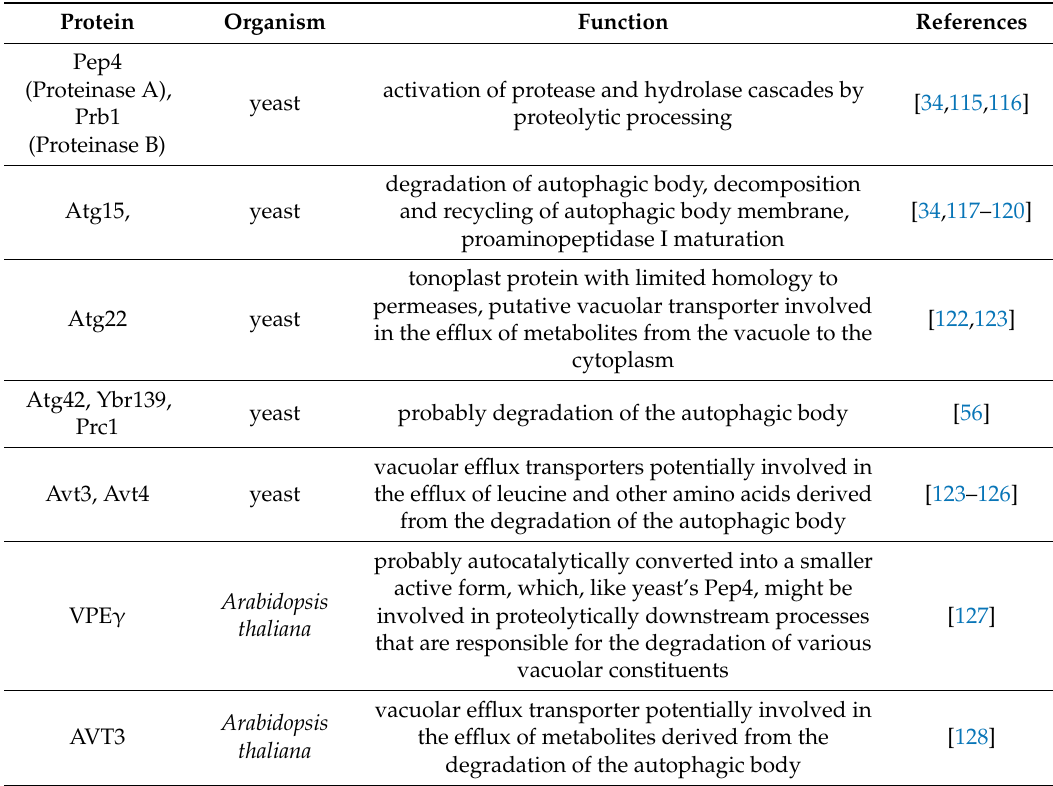
Table 3. Proteins involved, or hypothetically involved, in the degradation of the autophagic body